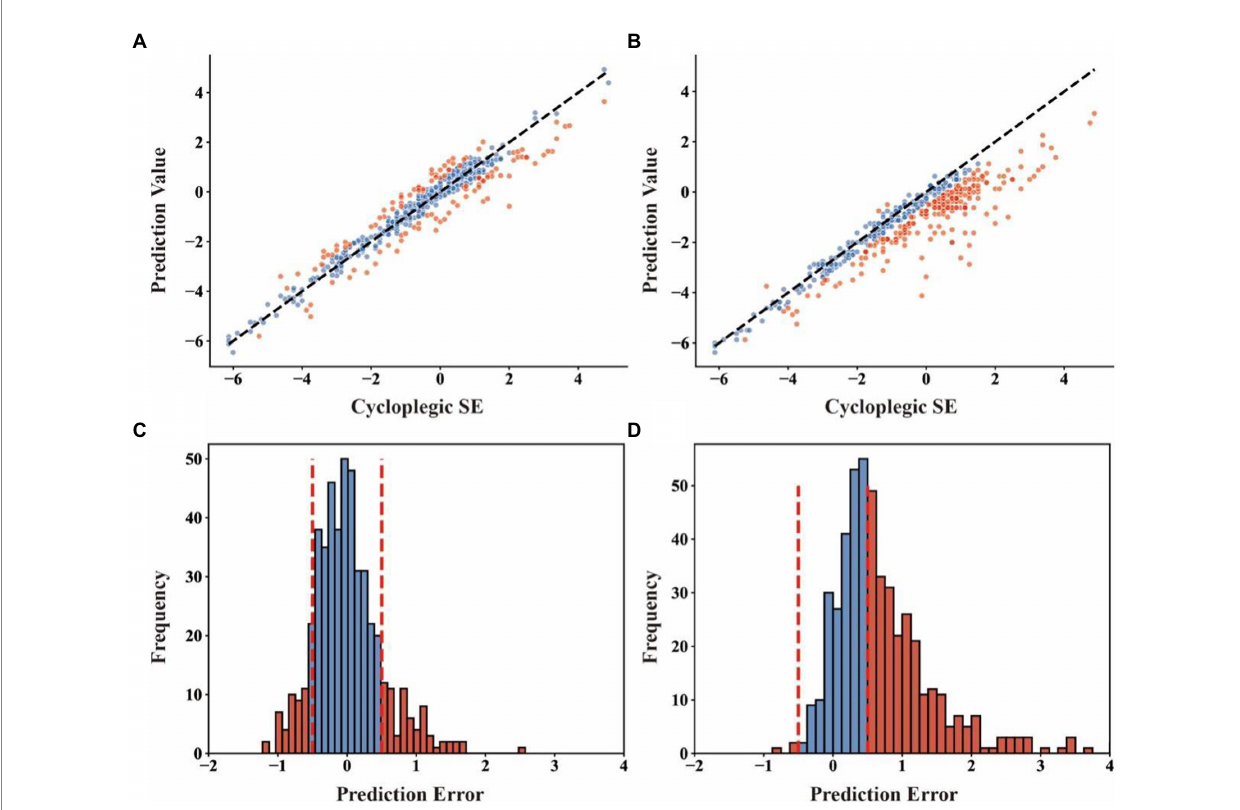
FIGURE 4 The scatter plot and distribution of prediction error of Adaboost regression model and directly using non-cycloplegic SE for the prediction of cycloplegic SE. (A) , the scatter plot with cycloplegic SE as the x-coordinate and predicted values from Adaboost regression model as the y-coordinate; (B) , the scatter plot with cycloplegic SE as the x-coordinates and predicted values directly using non-cycloplegic SE as the y-coordinates; (C) , the distribution of prediction errors by Adaboost regression model; (D) , the distribution of prediction errors by directly using non-cycloplegic SE. The red dots in (A) and (B) indicate the samples with prediction errors greater than 0.50D, and the vertical dashed lines in (C) and (D) indicate the boundary of the prediction error at